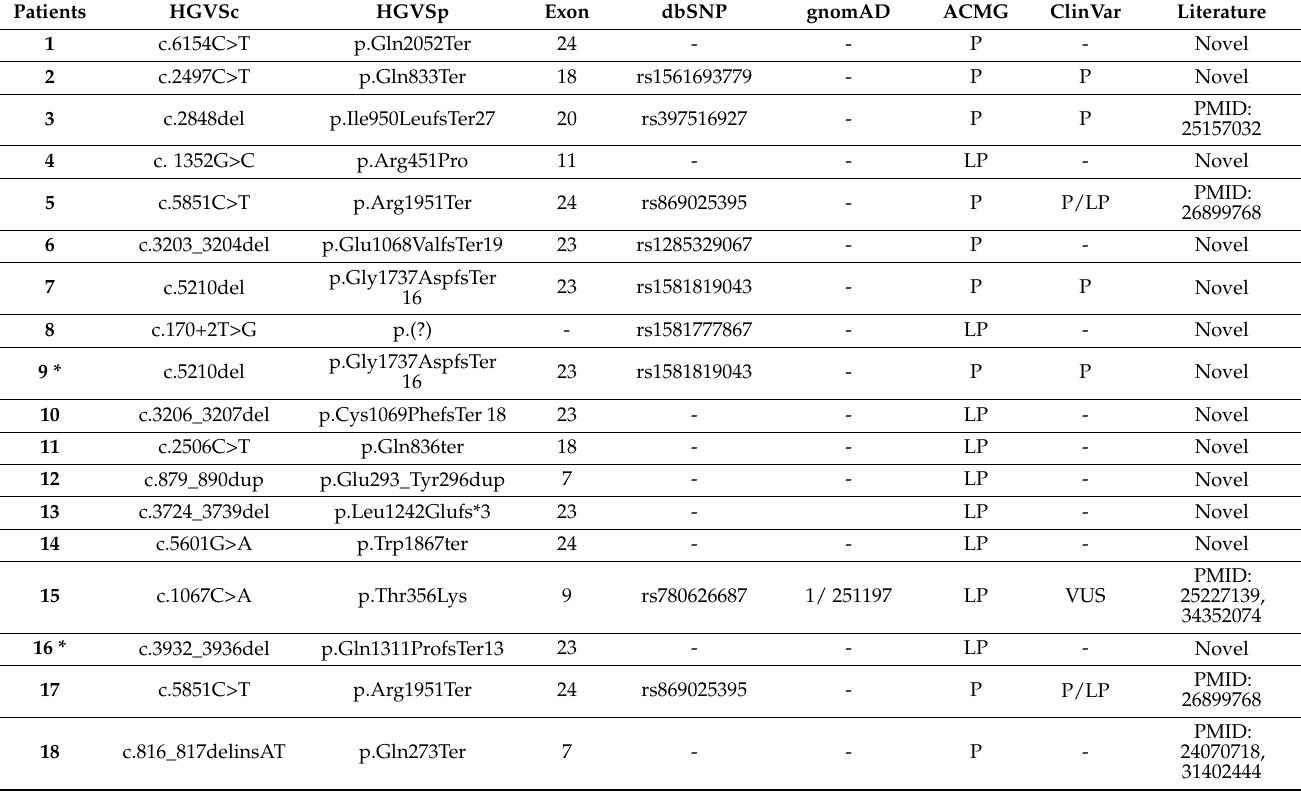
Table 1. Variants identified in desmoplakin (DSP NM_004415) gene by next generation sequencing (NGS) analysis in